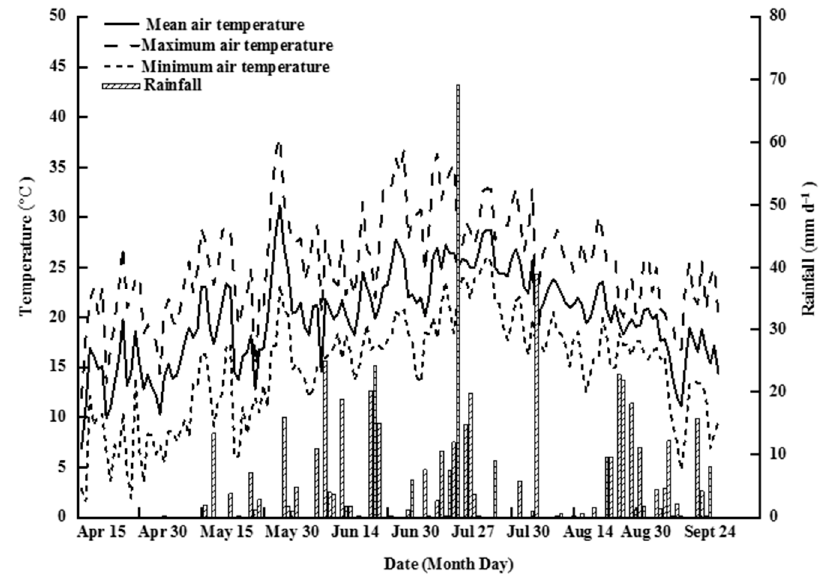
Figure 2. Climatic data for the rice-growing season.